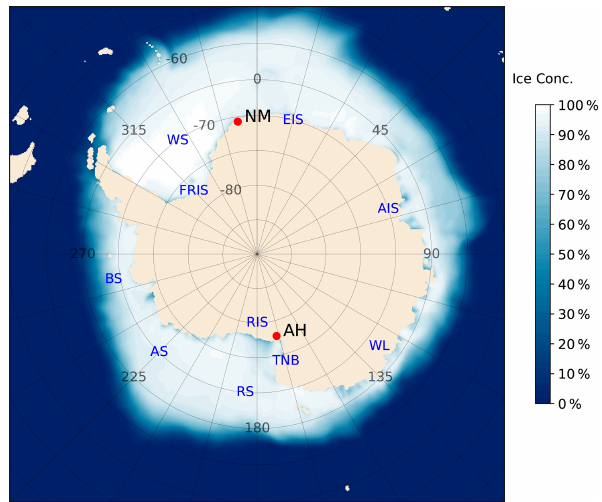
Figure 1. Location of AH and NM on the Antarctic continent (red dots). Blue to white colours indicate the mean (2003–2021) OSI- SAF sea ice concentration (see Sect. 2.6) from August to October. Land masses and shelf ice areas are shown in beige. The abbrevia- tions for the geographical names shown in blue are listed in Table